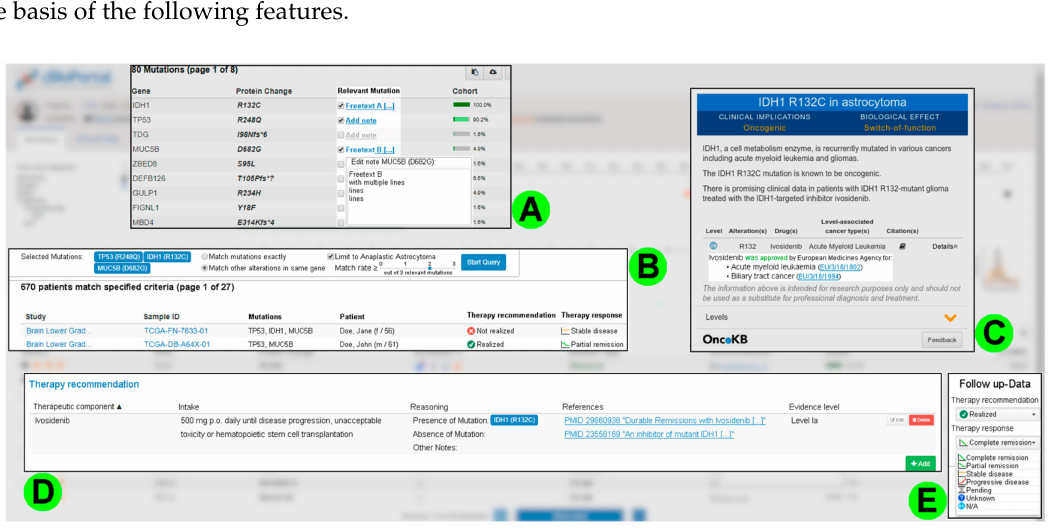
Figure 3. Collage demonstrating some requirements for the development and recording of a therapy recommendation. This collage depicts image sections from the screenshot mockups we created based on the original interface of cBioPortal: ( A ) Checkboxes and text fields in the mutation table of the patient view to mark potentially relevant mutations for the therapy recommendation. ( B ) Search functionality with automatic parameter transfer to find previous patient cases with a mutation pattern similar to that of the current patient. ( C ) Extension of OncoKB’s information to cover the European Medicines Agency’s (EMA) approval status of a given drug. ( D ) Summary of already entered components of the therapy recommendation for the current patient. ( E ) Option to record follow-up data for the current patient. Example data adopted from the public cBioPortal (https: // cbioportal.org) and OncoKB